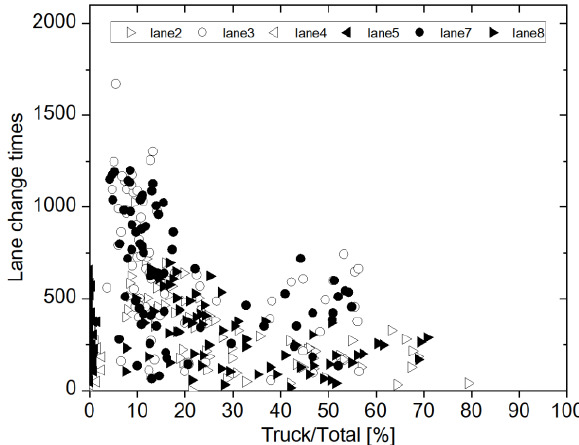
Figure 4. Total lane change times versus truck portion.